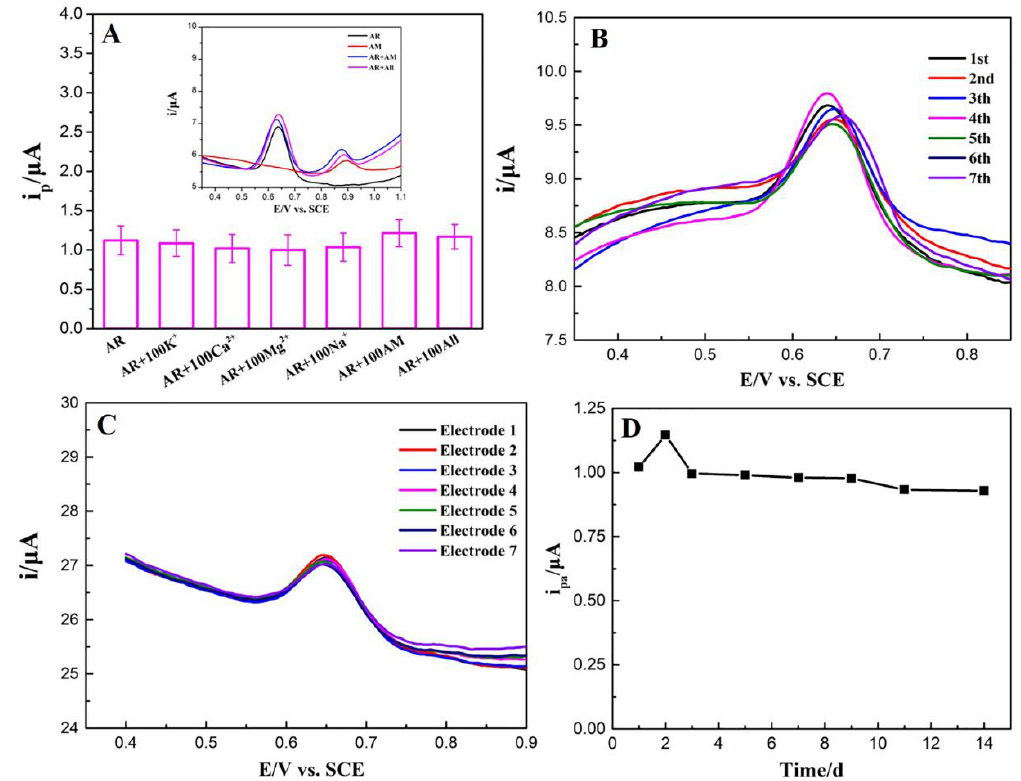
Figure 9. ( A ) Anodic peak current of Allura Red in the presence of 100-fold K + , Na + , Ca 2+ , Mg 2+ , and amaranth; ( B ) Seven successive measurements of Allura Red at the same TiO 2 /ErGO/GCE; ( C ) Anodic peak currents of Allura Red recorded at seven TiO 2 /ErGO/GCEs; ( D ) Anodic peak currents of Allura Red were regularly recorded during two weeks. The inset in Figure 9A is DPV of Allura Red in the existence of 100-fold amaranth and all interfering specifies. GCE: glass carbon